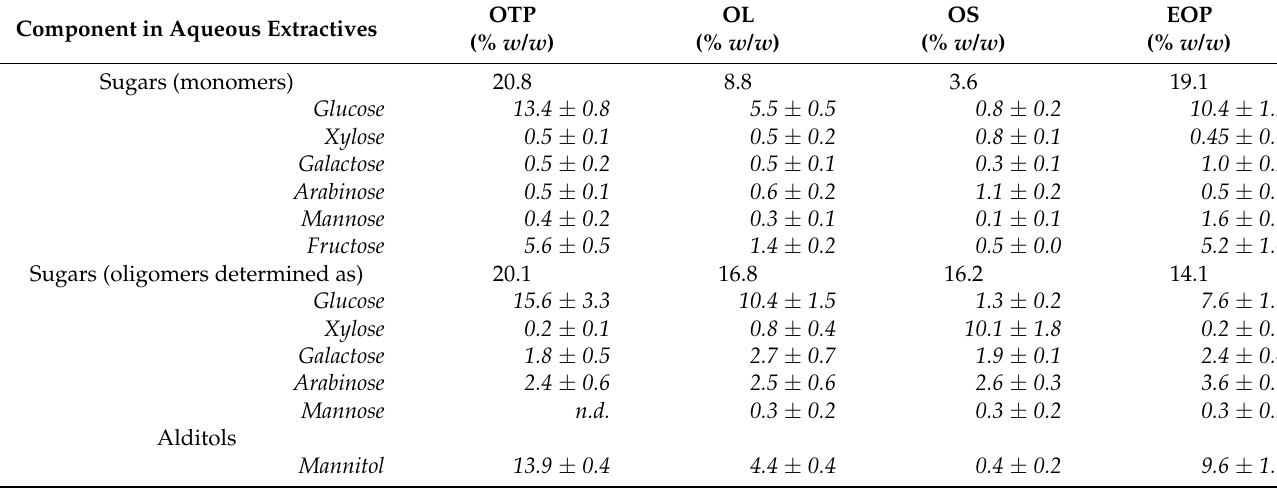
Table 2. Presence of water-extracted sugars and other related compounds for each olive by-product (% w/w of aqueous